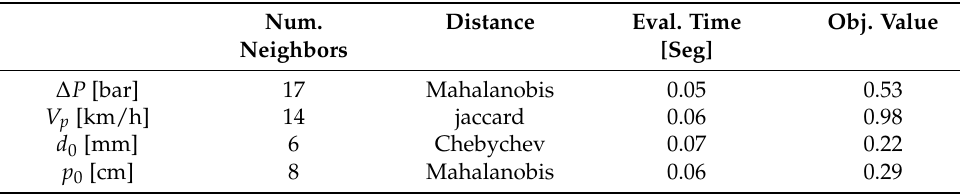
Table 8. k neighbors of the OPP soft-sensor found using optimization.